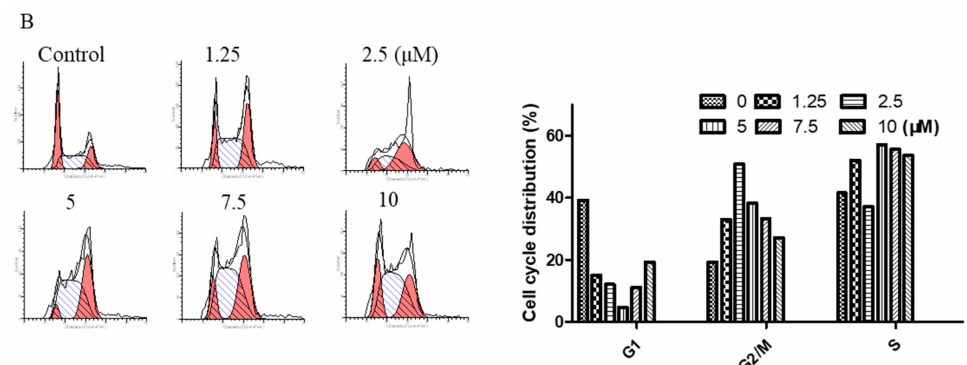
Figure 4. Arnicolide D induced cell cycle arrest at the G 2 / M phase. CNE-2 cells were treated with arnicolide D at 1.25–10 µ M for 24 h or 48 h and then assessed via flow cytometry. Representative DNA fluorescence histograms of PI-stained cells showing the cell cycle distribution for ( A ) 24 h or ( B ) 48 h. ( C , D ) Bar graphs show the proportion of CNE-2 cells in di ff erent phases. Values are shown as means ± SD and are representative of three independent experiments.